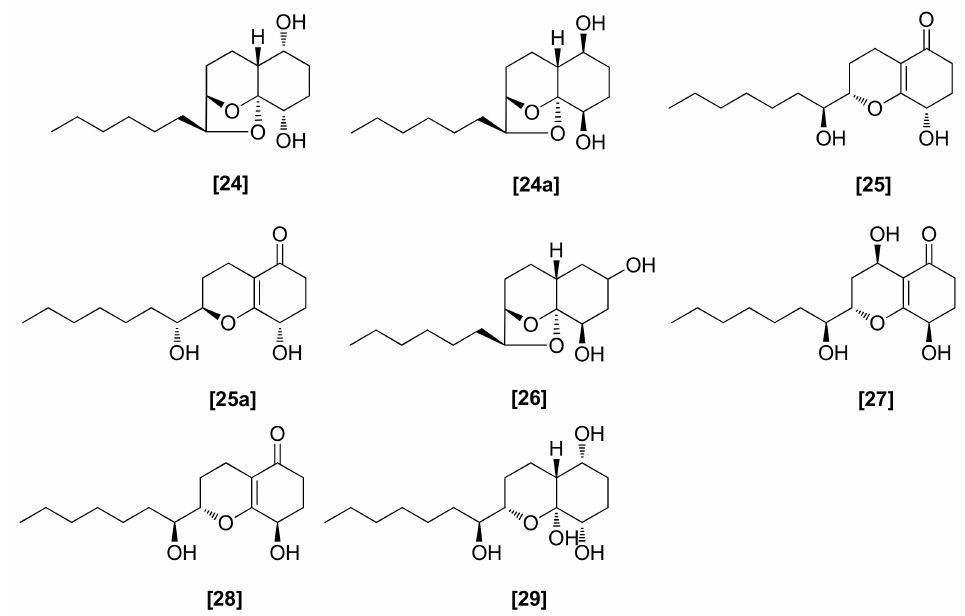
Figure 7. Structures of antifungal koninginins from Trichoderma spp.: [24] koninginin A, [25] koninginin B, [26] koninginin C, [27] koninginin D, [28] koninginin E, [29] koninginin G; koninginins [A], [B], [C], [D], and [E] were produced by T. koningii and koninginin [E] was produced by T. aureoviride . 2.8. Steroids